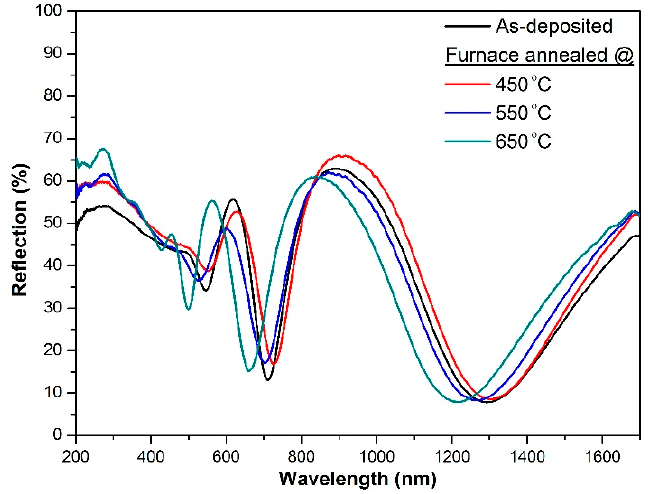
Figure 1. Reflectance spectra of furnace annealed amorphous silicon thin films at different temperatures.